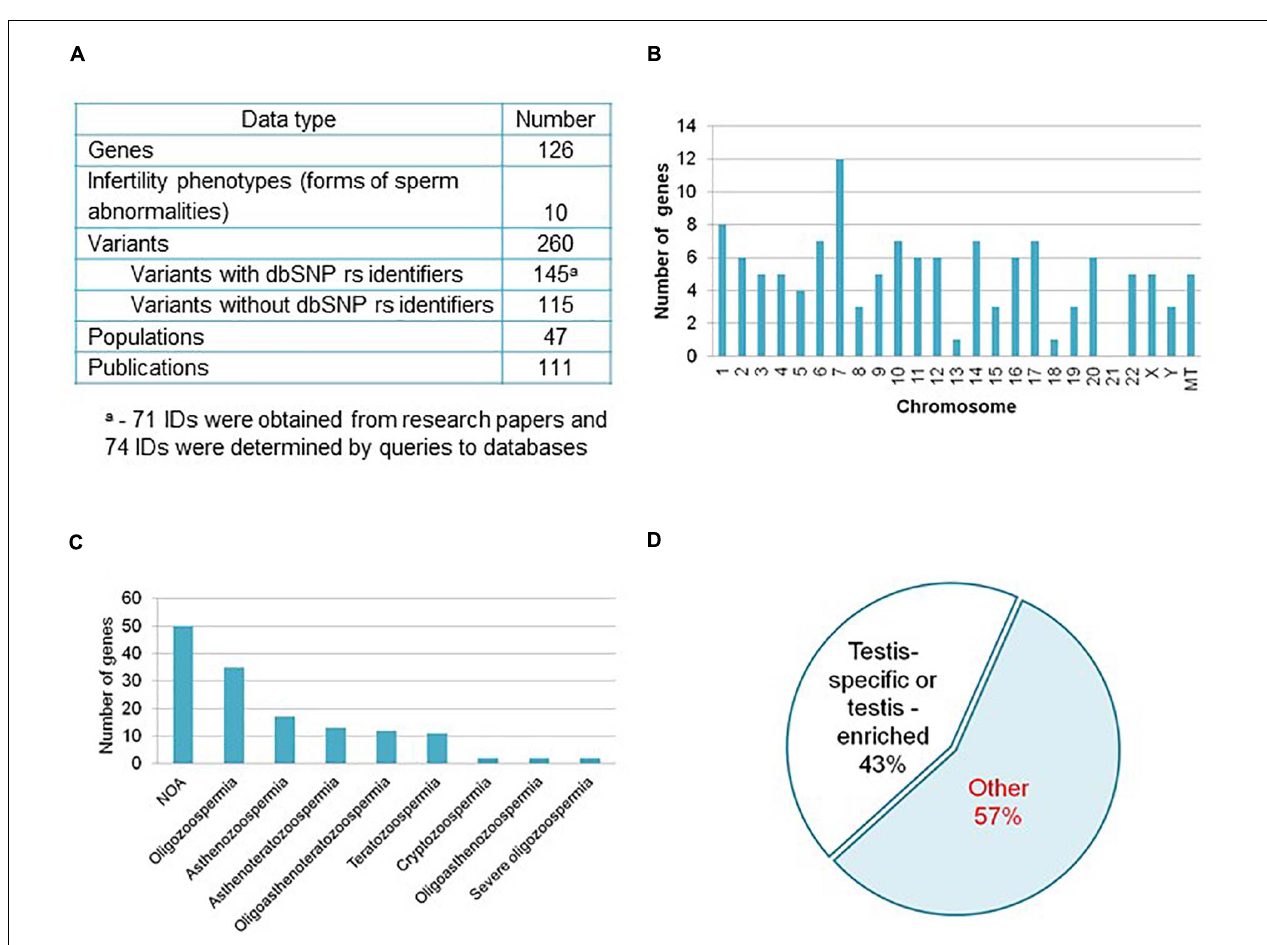
FIGURE 1 | Informational content of the catalog HGAPat. (A) HGAPat statistics. Queries to databases were performed according to the scheme presented in Supplementary Figure 1 . (B) Chromosomal localization of genes. MT stands for genes, located in mitochondrial DNA. (C) The number of genes associated with a specific form of pathozoospermia (NOA, non-obstructive azoospermia ). When calculating the number of genes associated with Teratozoospermia , genes associated with Globozoospermia were taken into account. (D) Proportion of genes, expressed in a testis-specific or testis-enriched manner.